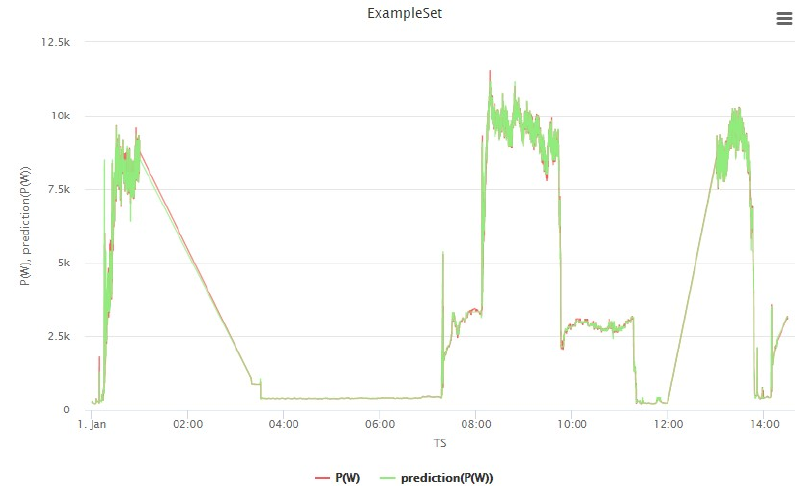
Figure 19. Visualization graph of DT model.